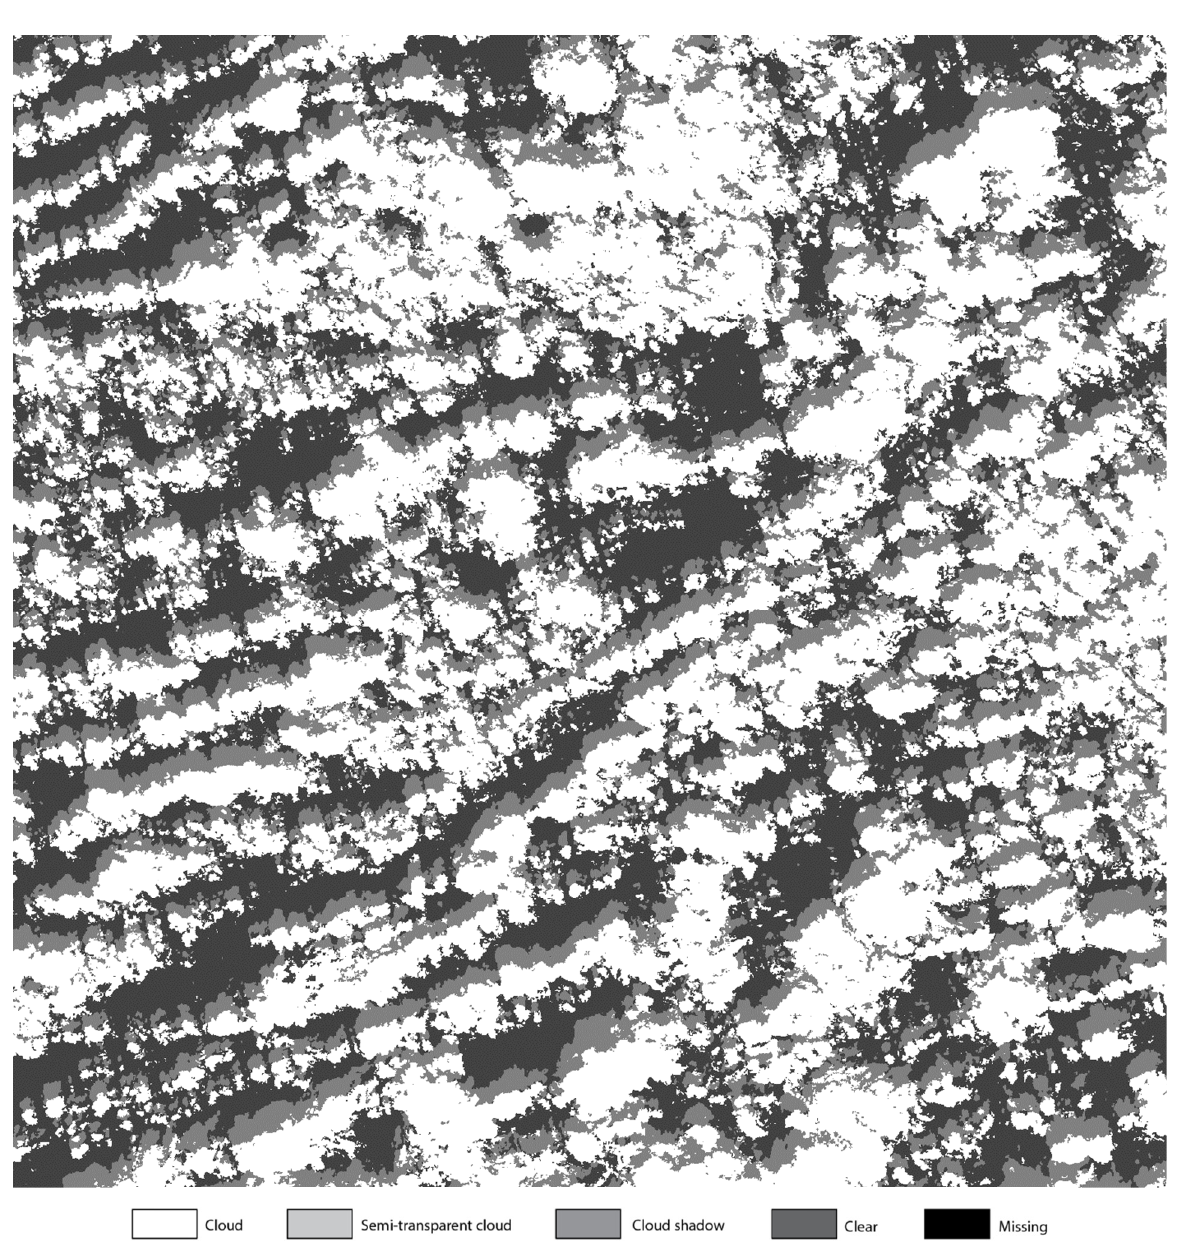
Figure A1. The entire Sentinel-2 L2A product classification map at 10 m resolution output (S-2 product